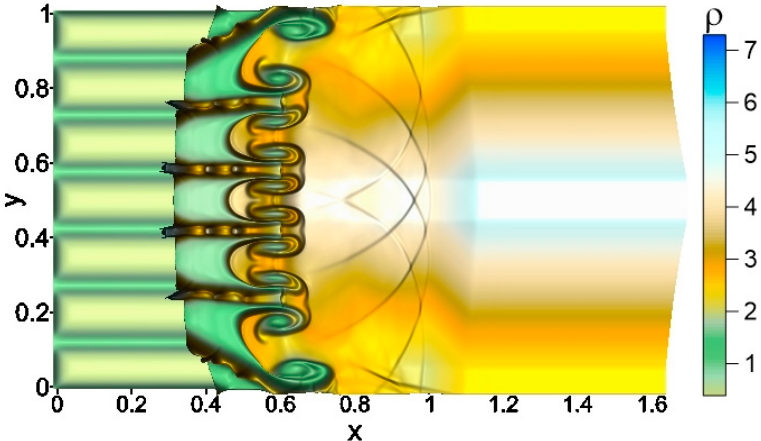
Figure 16. Manifestation of the Richtmyer-Meshkov instabilities in a case of wider layers, density, M = 3, α = 0.4.